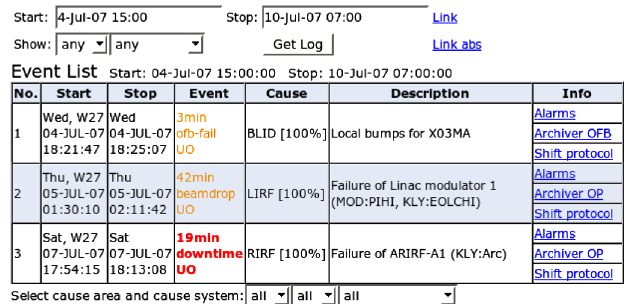
FIG. 4. (Color) Example screen shot of the event browser Web page.